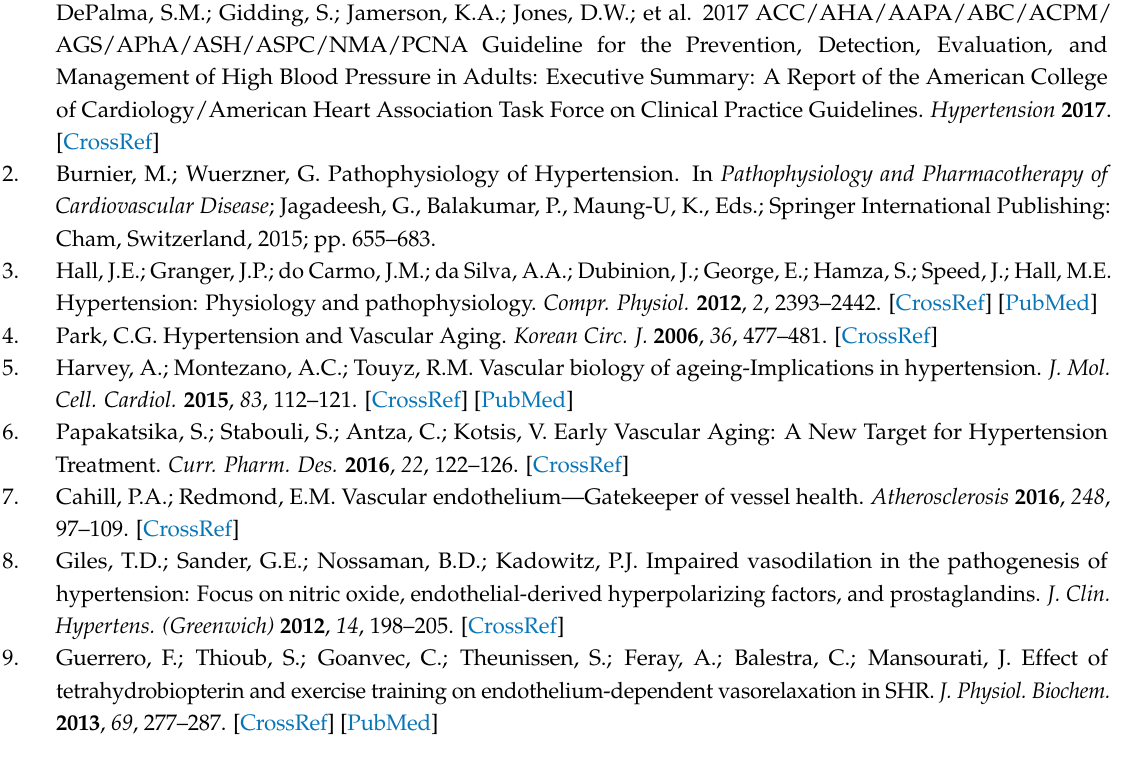
Figure S1: The SDS-PAGE and immunoblots of insulin receptor (insulin R), insulin-like growth factor-1 receptor (IGF-1 R), phospho-protein kinase B (p-Akt), protein kinase B (Akt), phospho-endothelial nitric oxide synthase (p-eNOS), endothelial nitric oxide synthase (eNOS), and actin extracted from thoracic aortas among the WKY, SHR, and SHR+PCA